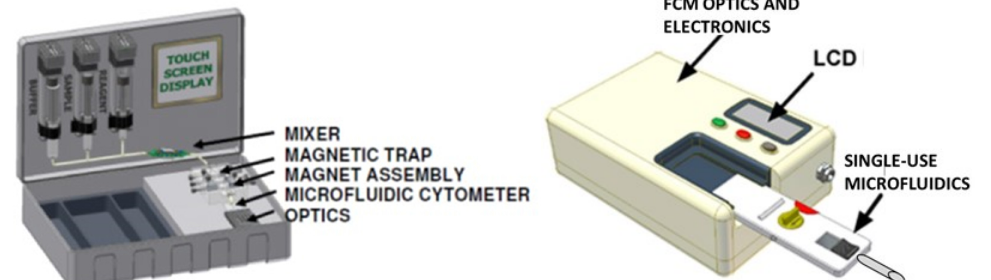
Figure 10. ( Left ): Concept for an automated point-of-care portable rare cell detection system using the components developed in this research. ( Right ): Concept for an add-on miniature dedicated flow cytometer [16] with a single-use microfluidics cartridge [4,11] to receive captured cells flushed out of the magnetic trap.